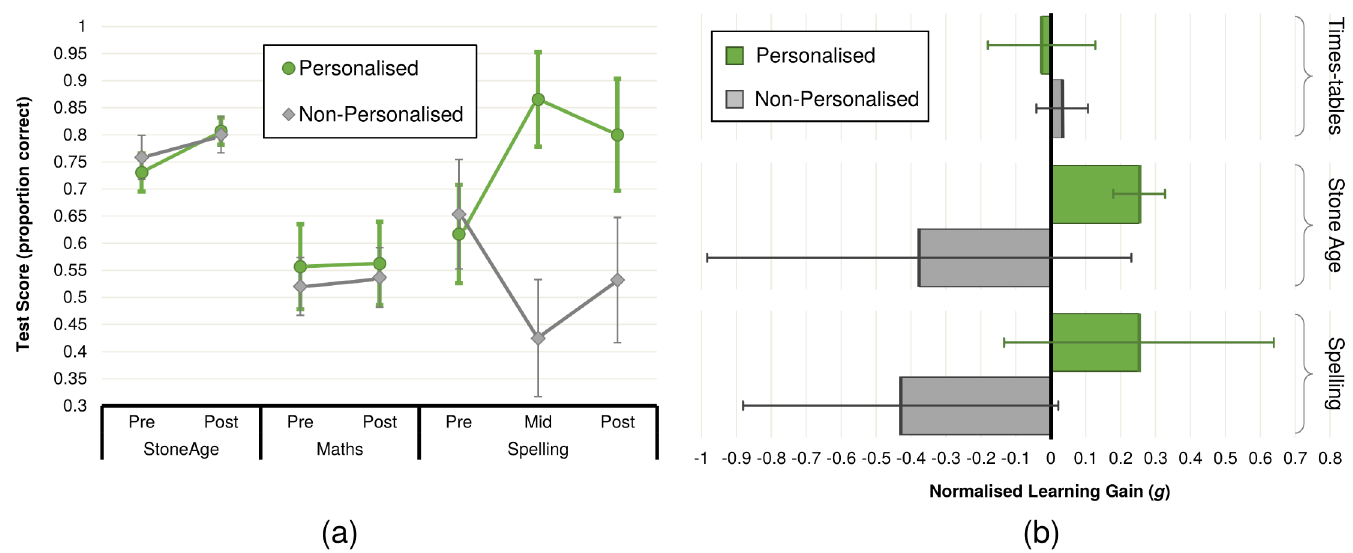
Fig 4. Child learning performance between conditions. (a) summary of mean percentage test scores (for pre and post experimental period)for the familiar learningtask (times-tables), the novel learningtask (the stone age), and the independent task (spelling,for which there was also a mid-experiment test); (b) normalised learninggain exhibitedin the familiar, the novel, and the independentlearningtasks. Error bars show 95% CI.